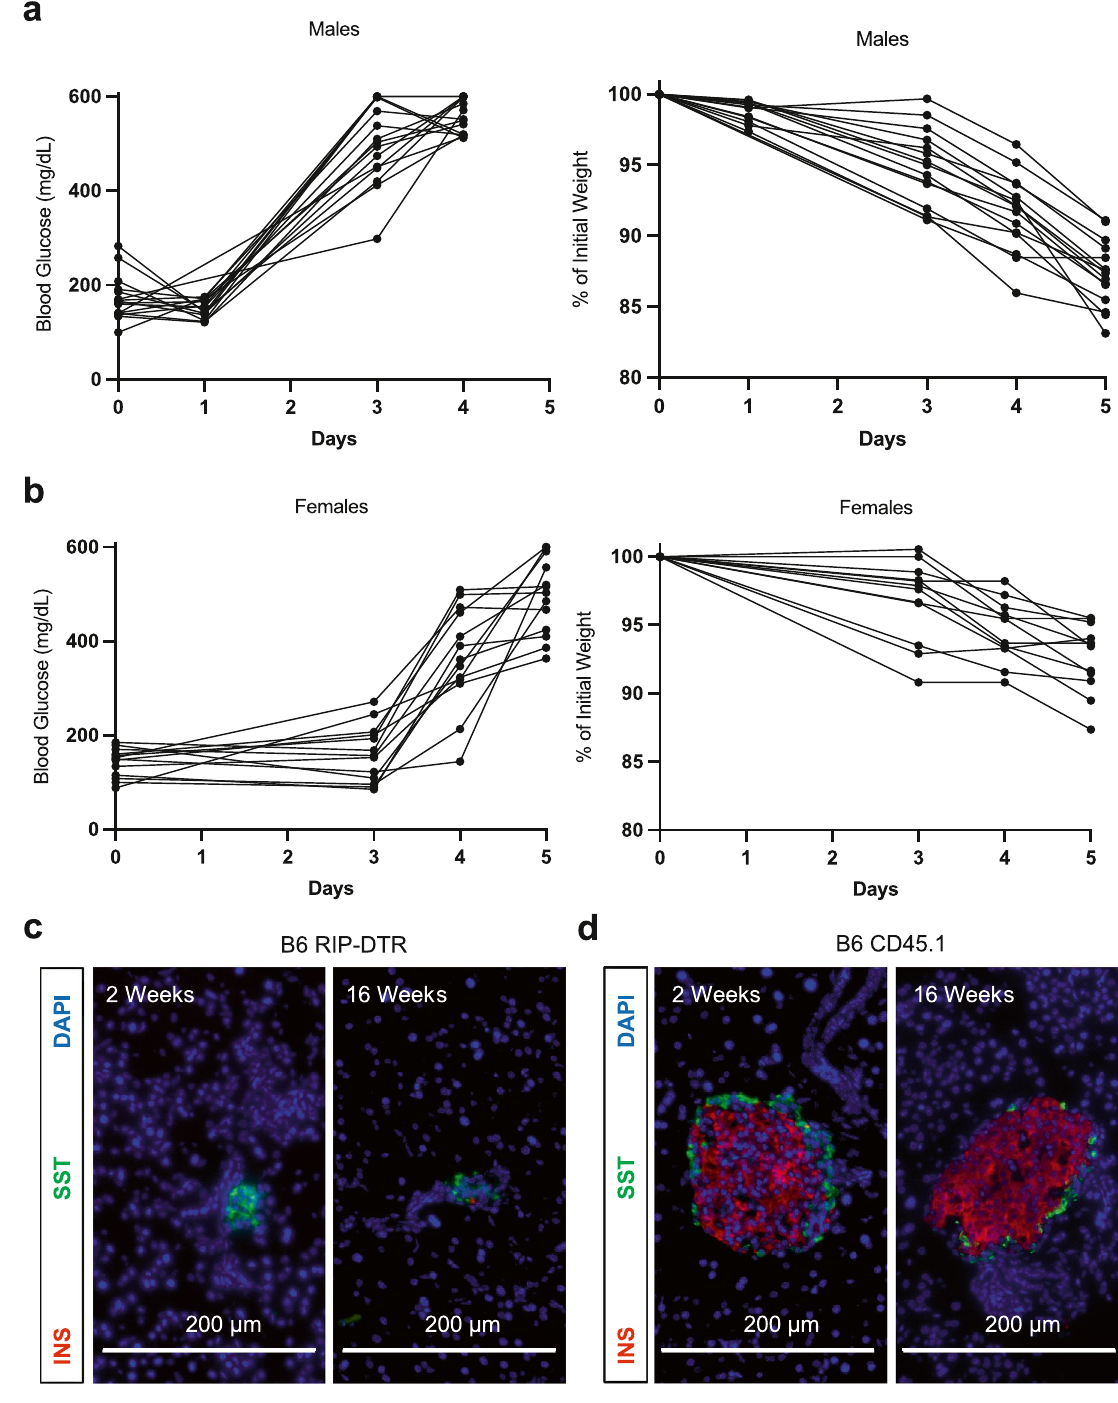
Figure 2. Diabetes in RIP-DTR mice after DT administration. ( a ) Non-fasting blood glucose and percentage of starting weight in RIP-DTR mice after single dose administration of DT (i.p.) in n = 16 hemizygous males and ( b ) n = 13 homozygous females. DT was injected on day 0 after baseline non-fasting blood glucose was recorded. Mice were between 8 and 24 weeks of age at time of injection, and no exogenous insulin was administered. ( c ) Representative histology of pancreas taken at 2 weeks and 4 months from B6 RIP-DTR or ( d ) B6 CD45.1 mice given single dose of DT. After confirming hyperglycemia on two consecutive days, we maintained the health of diabetic B6 RIP-DTR mice up to the 2-week timepoint by providing 40 U/kg exogeneous insulin daily. To maintain diabetic B6 RIP-DTR mice to 4 months, insulin pellets (“Methods”) were administered subcutaneously after confirmation of hyperglycemia on two consecutive days. INS Insulin, SST